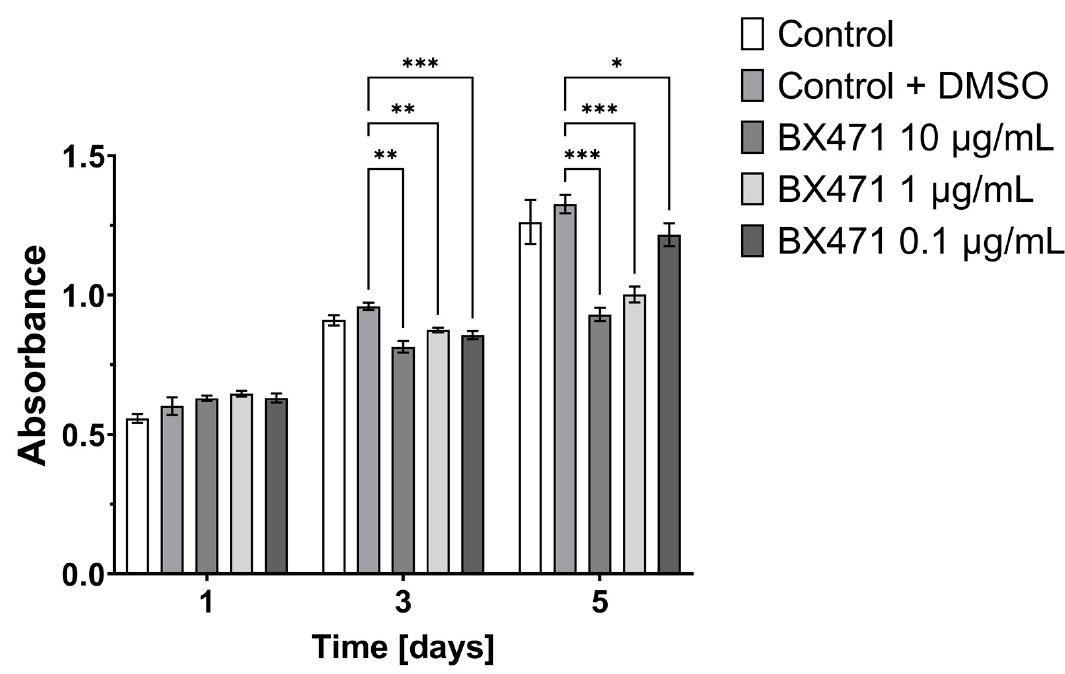
Figure 3. Effect of CCR1 receptors blockade by the antagonist BX471 on the CT26 cell proliferation. Each experiment was performed in three replicates. One, two, or three asterisk symbols denote significant results at p < 0.05, p < 0.01, or p < 0.001, respectively.